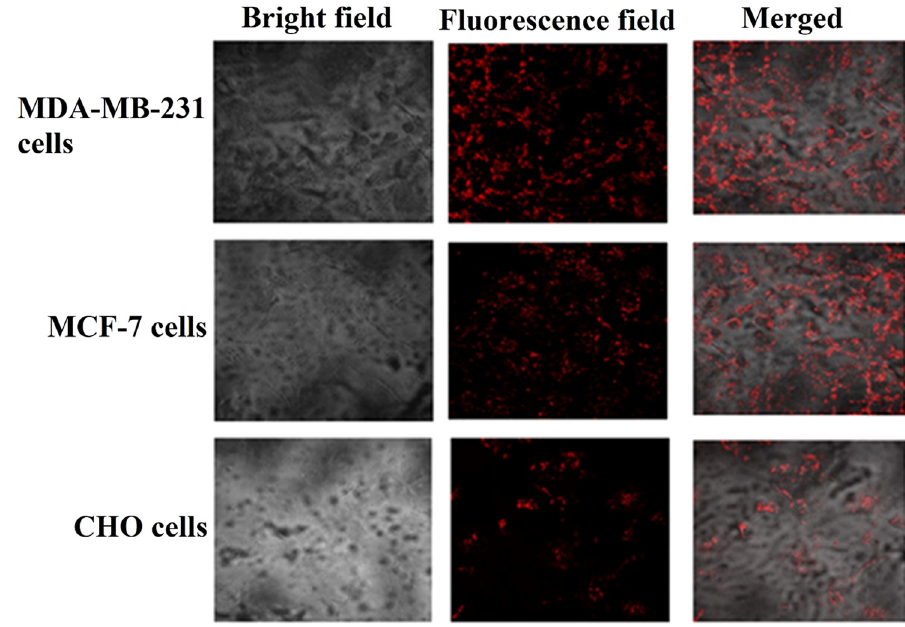
Figure 3: The MTX - AuNPs - CS - AS1411 cellular uptake by the cell lines using confocal fl uorescence